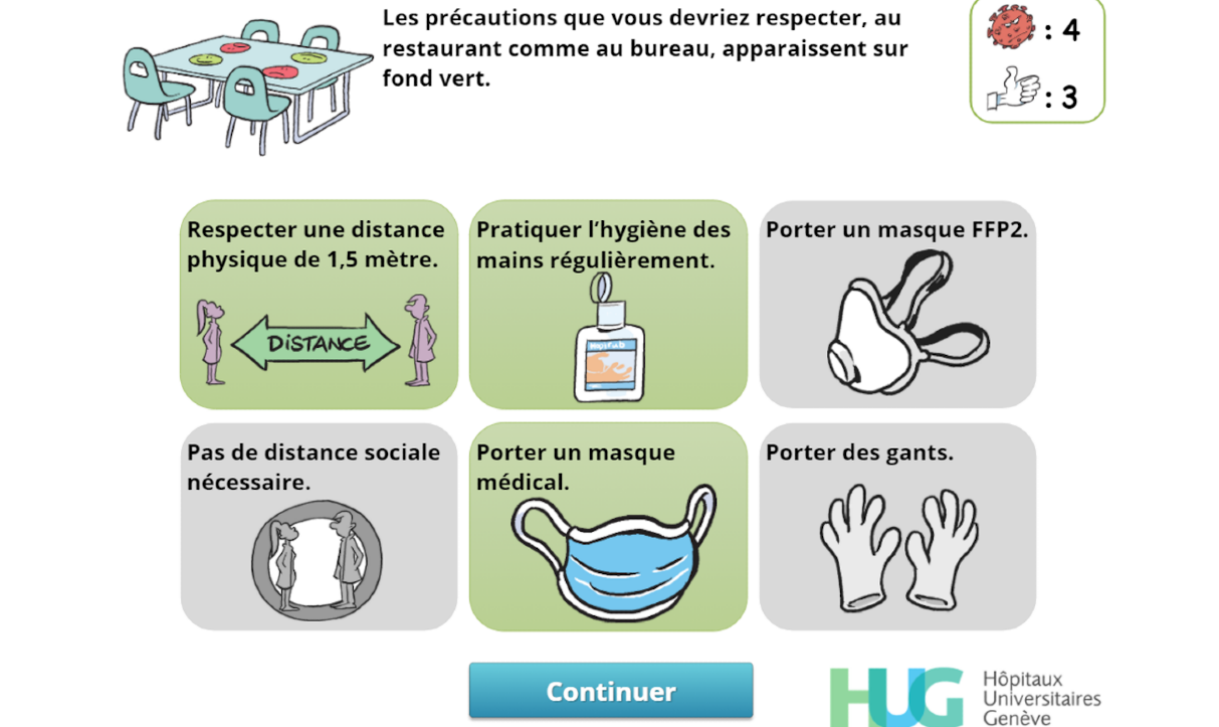
Figure 7. Feedback. When the user has failed to correctly answer the question, the correct answers are displayed with a green background.